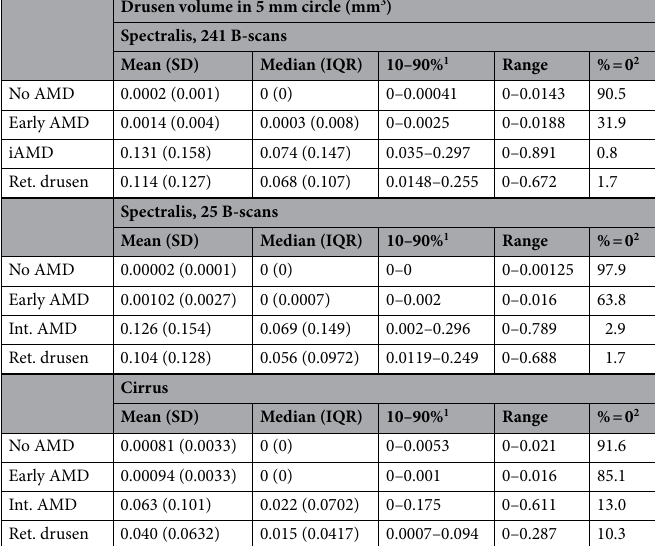
Table 2. Summary statistics for different drusen volume measurements. SD standard deviation, IQR interquartile range, AMD age-related macular degeneration, eAMD early AMD, iAMD intermediate AMD, SBP systolic blood pressure, BCVA best-corrected visual acuity. 1 10–90% indicates 10 and 90% distribution quantiles. 2 % = 0 indicates percentage of values with undetected drusen (equal to